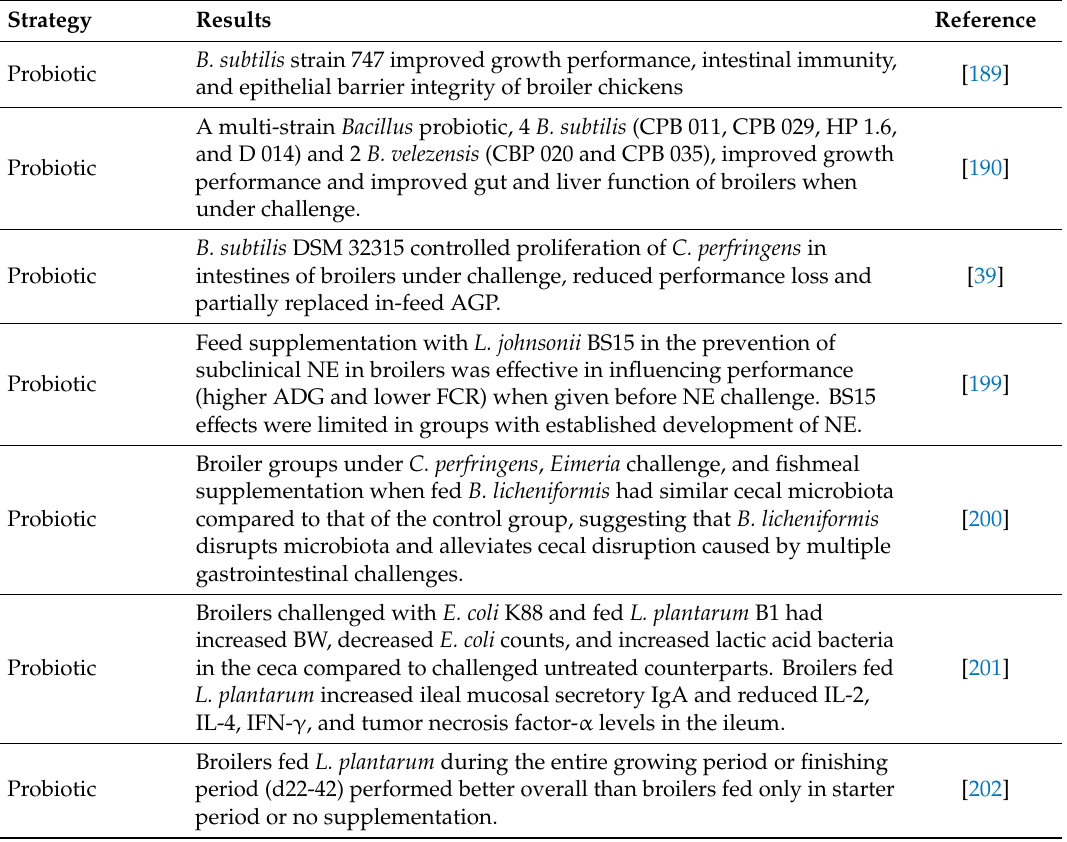
Strategy Results